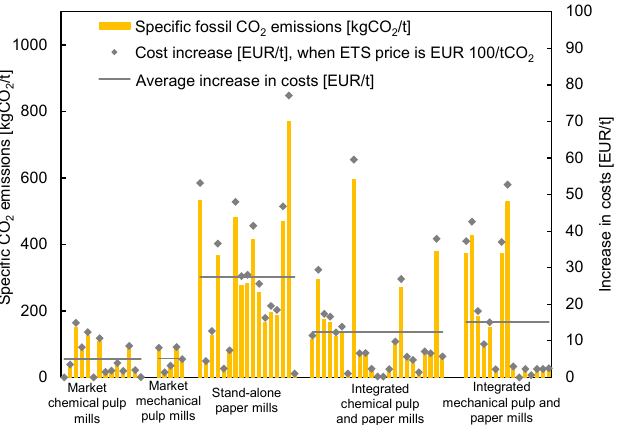
Figure 2. Impact of high EU ETS carbon prices (EUR 100/tCO 2 ) on the production costs of different mill